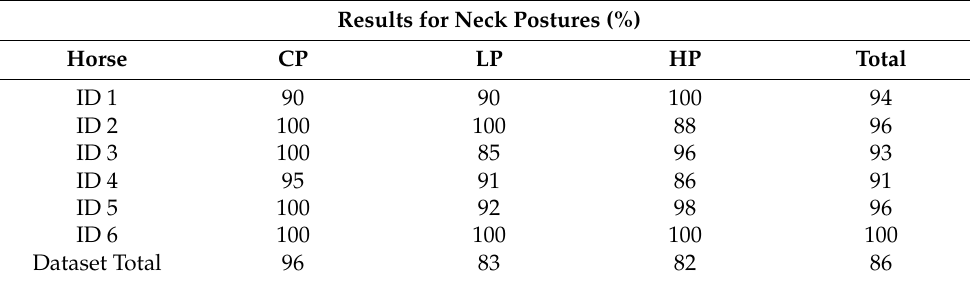
Table 2. The canonical variate analysis (CVA) cross-validated results for neck postures of individual horses (ID 1, ID 2, ID 3, ID 4, ID 5, ID 6) and group membership (Dataset Total) according to the three feeding positions: on the ground—control position (CP); neck held 15 ± 3 ◦ below withers height height with low hay net position (LP); neck held 15 ± 3° above withers height with high hay net with low hay net position (LP); neck held 15 ± 3 ◦ above withers height with high hay net position position (HP). Values are expressed as percentages. (HP). Values are expressed as percentages. Results for Neck Postures (%)